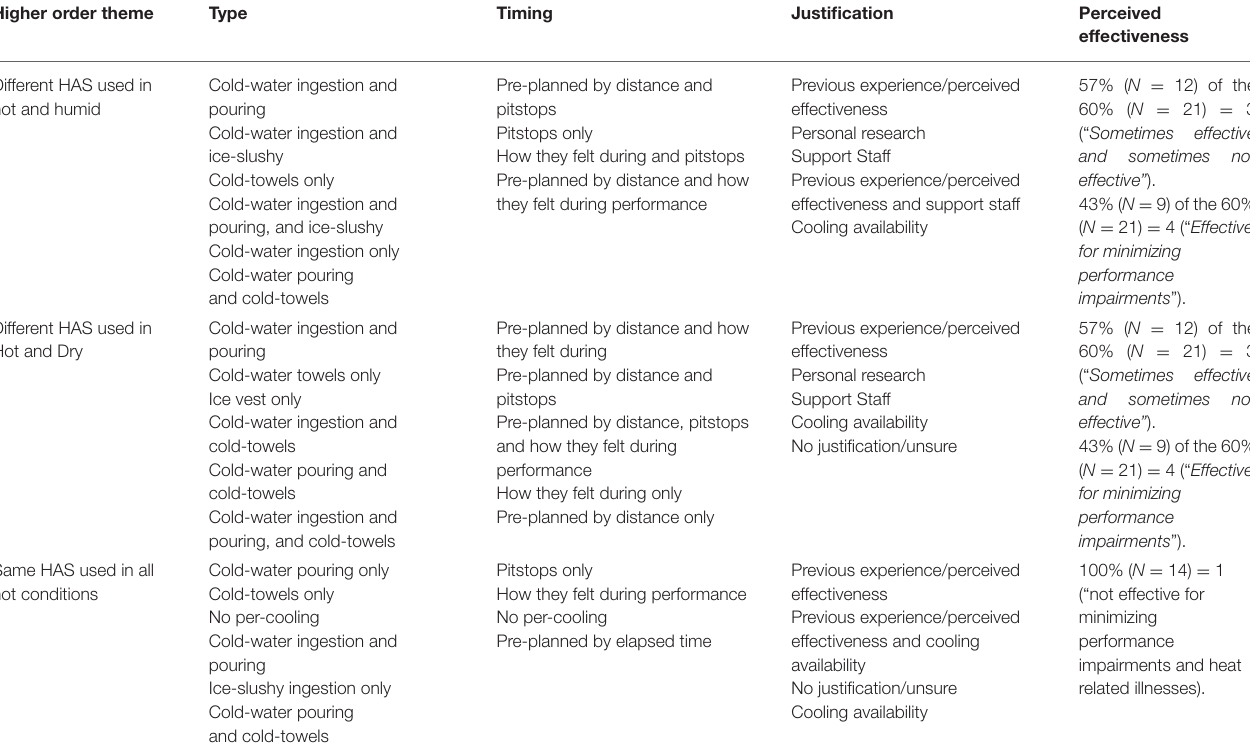
TABLE 3 | Athletes’ classification and their most prevalent descriptive key terms. Higher order